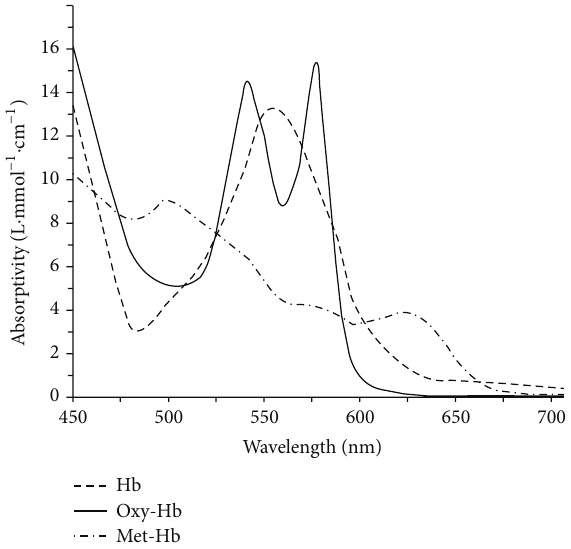
Figure 2: Absorbance as a function of wavelength for oxyhe- moglobin, reduced hemoglobin, and methemoglobin. Transmission pulse oximetry utilizes absorbance at two wavelengths (here red 660nm and infrared 910nm) to determine the oxygen saturation of an arterial pulsation of blood into the skin. Adapted from